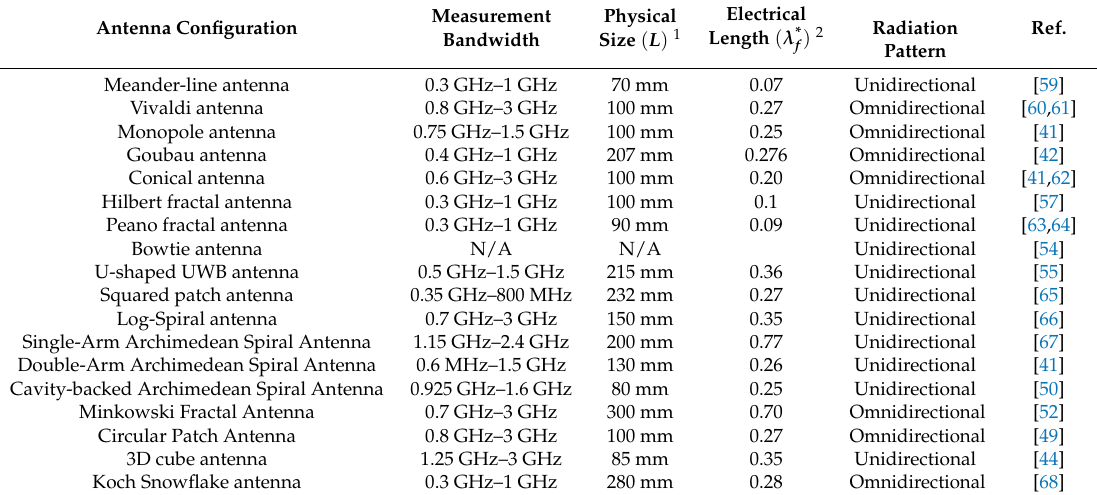
Table 3. Comparison of UHF sensors proposed in PD detection.